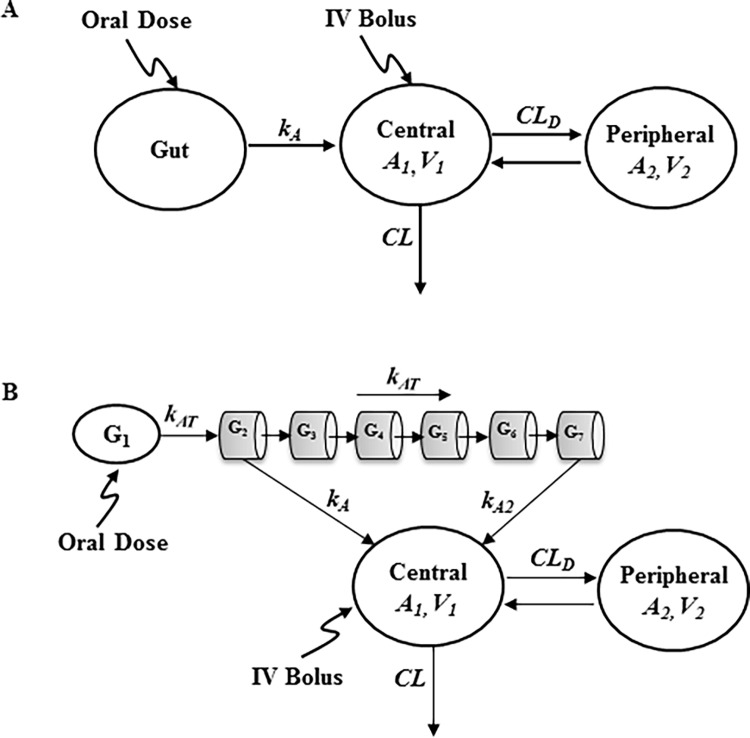
A two-compartment PK model with a first-order absorption for SHetA2 in mice and rats (A) and with a gastrointestinal transit absorption in dogs that accounts for SHetA2 transit through serial compartments after oral administration in dogs (B).